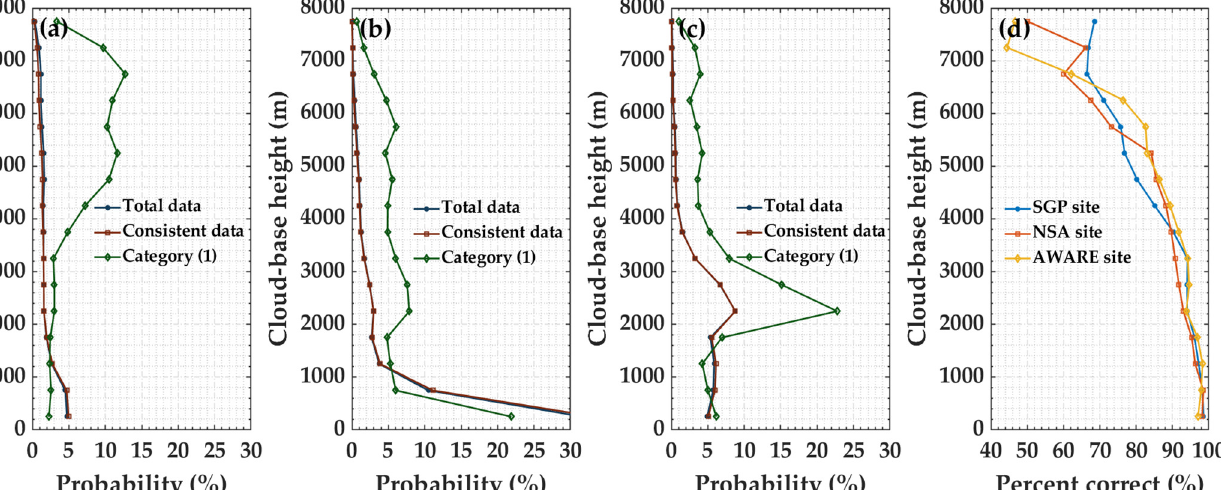
Figure 6. ( a ) Measurement of AERI under different cloud-base heights. ( b ) Backscattered echo of ceilometer from 0000 UTC to 0500 UTC on 1 January 2015. Background parts represent the corre- sponding time of the spectra in ( a ). 4.3. Performance Evaluation in Different CODs The temporal resolution of CODs from RADFLUXANAL Value-Added Product is about 20 s, and we perform time-matching between AERI measurement data and CODs. As shown in Figure 7, it can be seen that the distribution of total data and consistent data is basically the same, while the distribution of category (1) is basically concentrated during small COD. Compared with the SGP site, the COD in polar regions is smaller. At the AWARE site, in particular, the COD is no more than 10. Figure 7d displays that the pro- posed algorithm maintains a high accuracy at the AWARE site under any COD ( PC is about 95%). At the SGP site, the proposed algorithm is significantly related to COD. When the COD is less than 5, PC will drop below 80%, making it difficult to realize accurate identification of cloud. According to Sections 4.2 and 4.3, we find that optical thin clouds